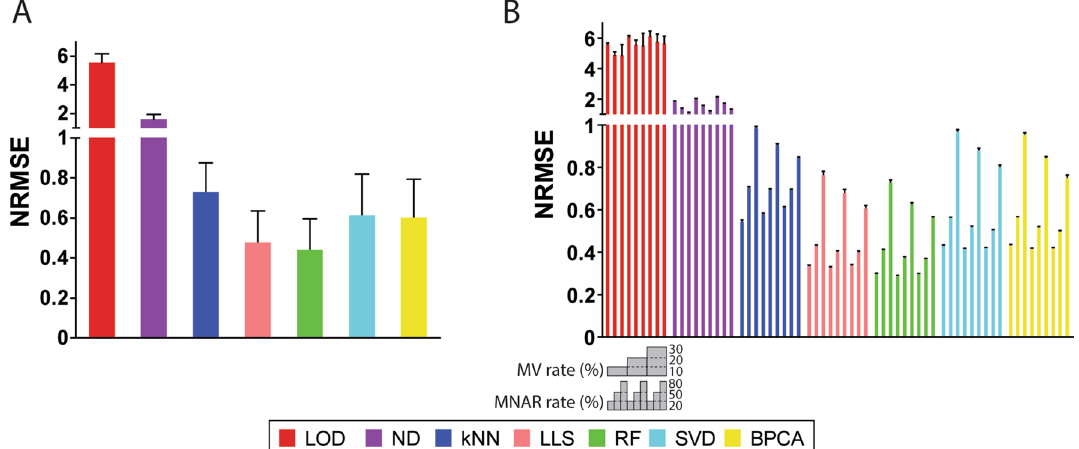
Figure 5. NRMSE of protein abundances with the immune cell dataset. ( A ) Overall NRMSE of protein abundances of seven imputation methods. Bars represent average values of all ninety repeats, and error bars represent standard deviations. ( B ) NRMSE of protein abundances in nine MV-MNAR conditions. Bars represent average values of ten repeats in each MV-MNAR condition, and error bars represent standard deviations. Nine MV-MNAR conditions are (from left to right): 10%MV-20%MNAR, 10%MV-50%MNAR, 10%MV-80%MNAR, 20%MV-20%MNAR, 20%MV-50%MNAR, 20%MV-80%MNAR, 30%MV-20%MNAR,